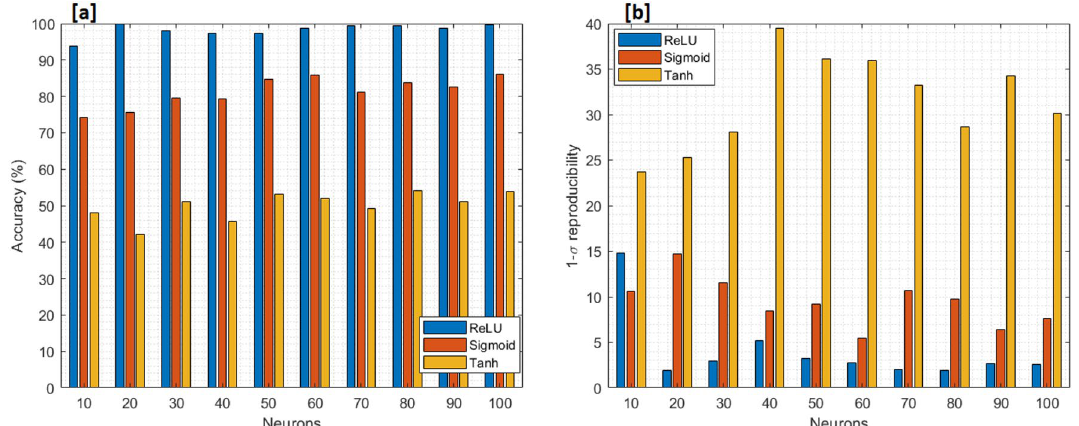
Figure 4. Comparison of ( a ) accuracy, and ( b ) 1- σ repeatability for the three activation functions used with different neurons: Tanh (orange), Sigmoid (red), Rectifier Linear Unit (blue).